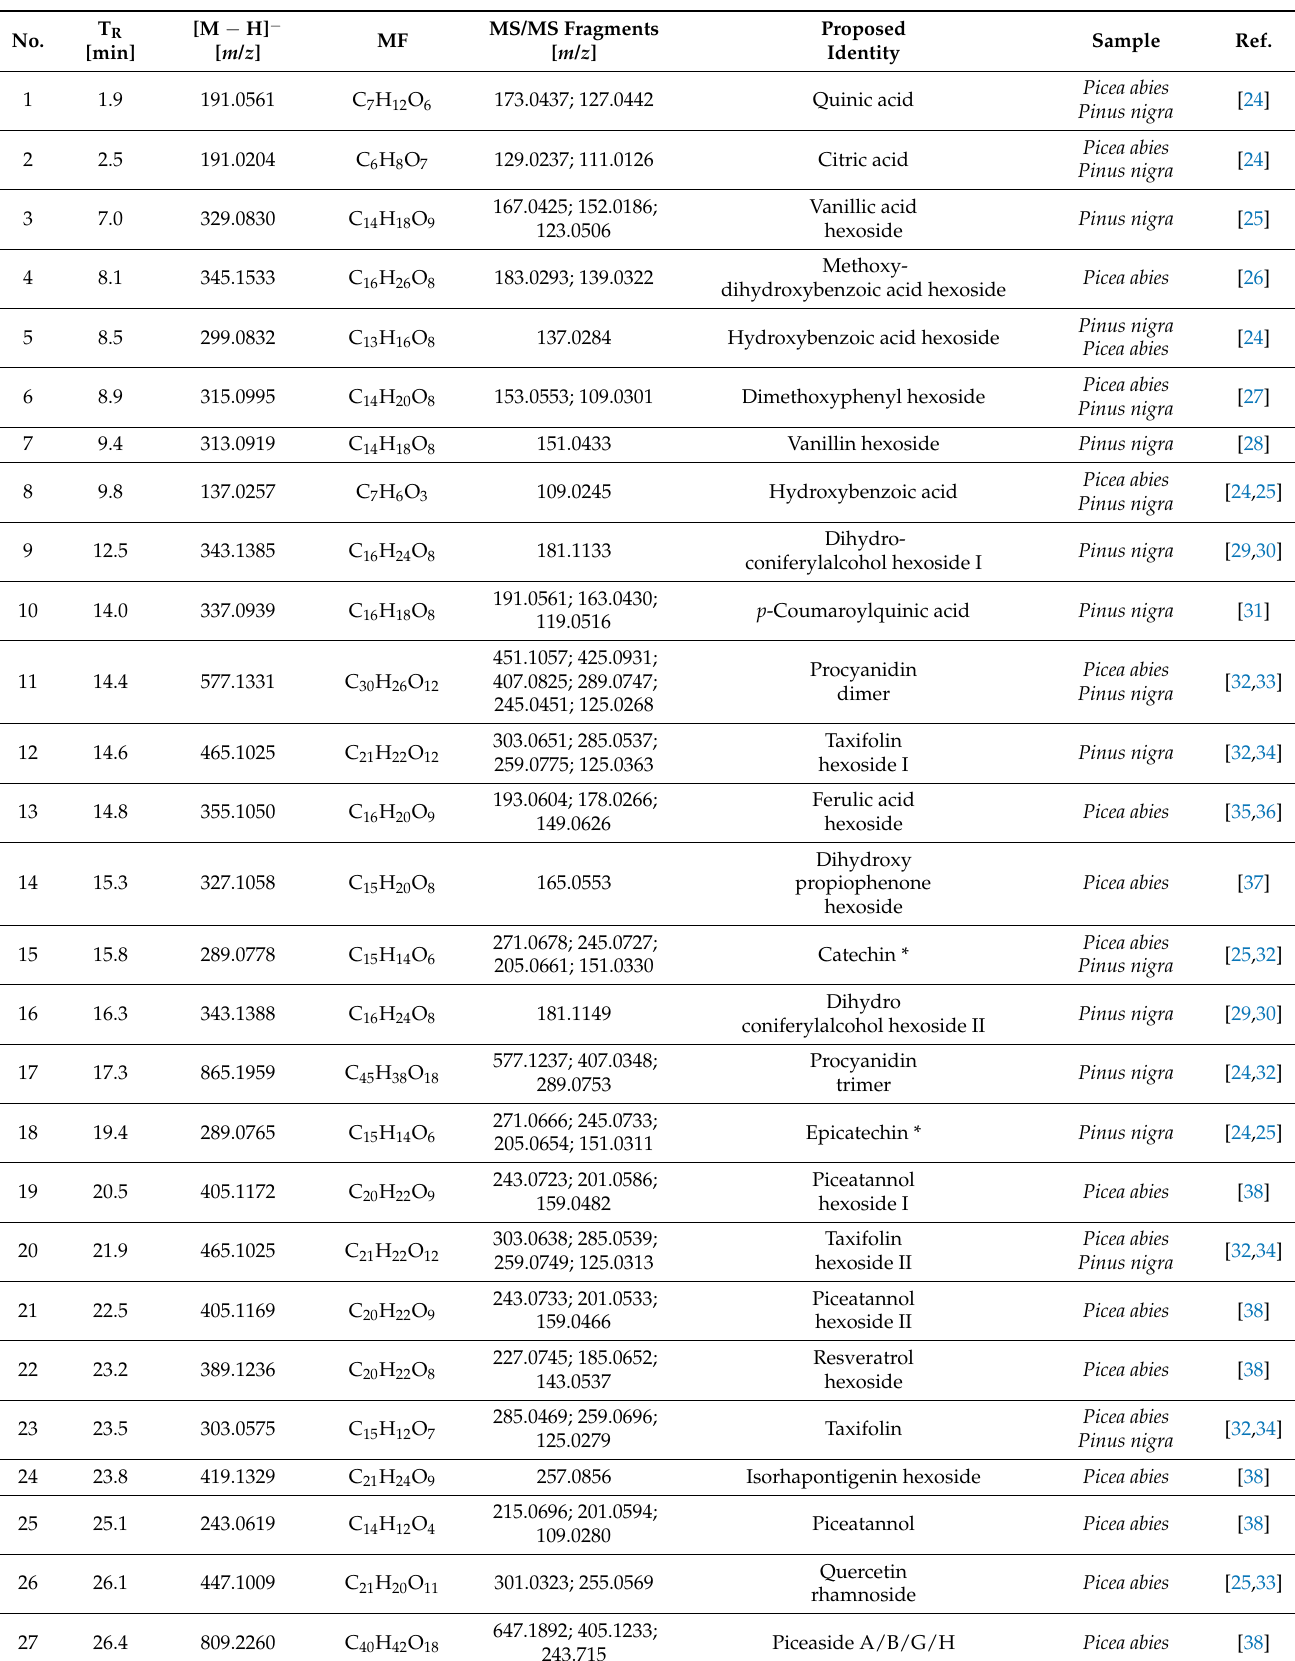
Table 1. Compounds tentatively identified in Picea abies and Pinus nigra aqueous bark